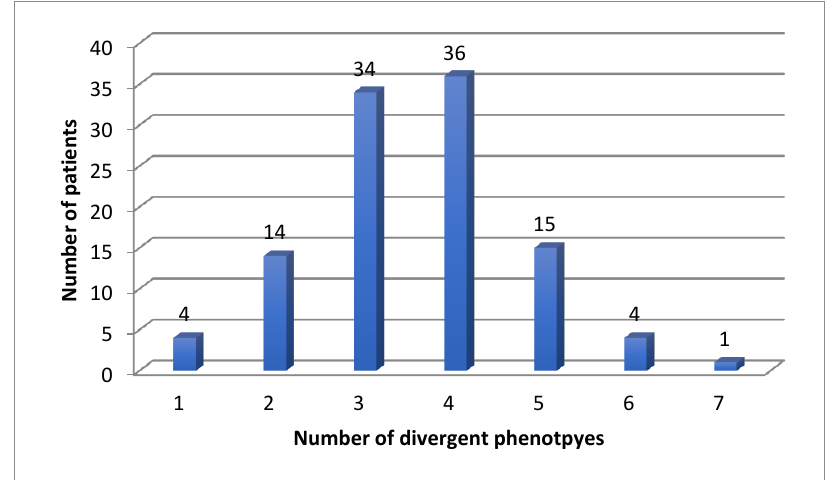
Figure 1. Number of divergent phenotypes for CYP enzymes in 108 patients.